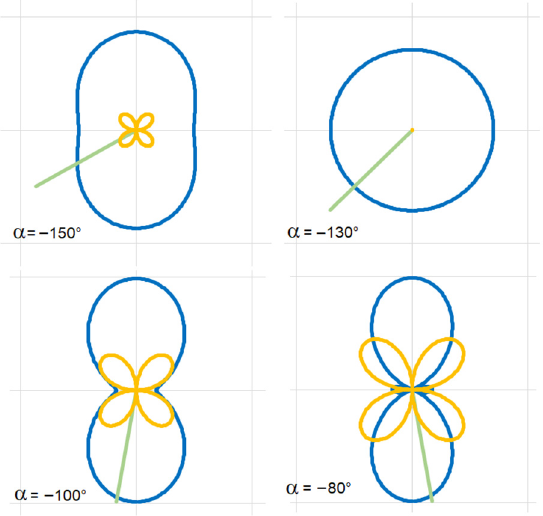
Figure 2. Symmetric tensor glyphs: 𝛼 = −150°, −135°, −100°,and − 80° .